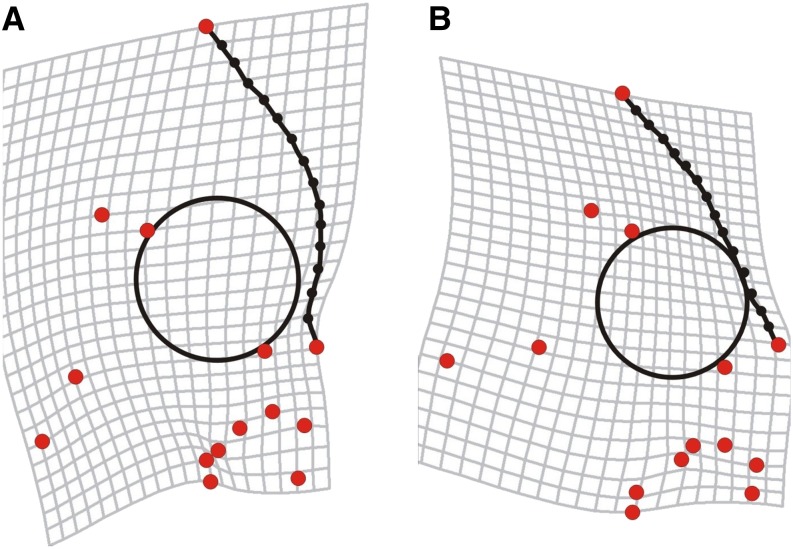
Morphological differences that occur between sexes within an F2 hybrid population of Tropheops sp. “red cheek” and Labeotropheus fueleborni. Males are depicted by (A) and have a steeper craniofacial profile, whereas females (B) have a more gradually sloping profile. Figures are created by regressing landmarks against discriminant function scores. Differences are magnified 3× to aid in interpretation.